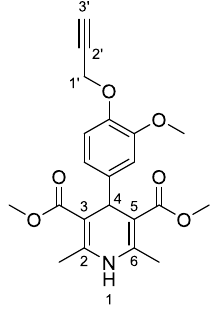
Figure 4. Chemical stucture of 3c .